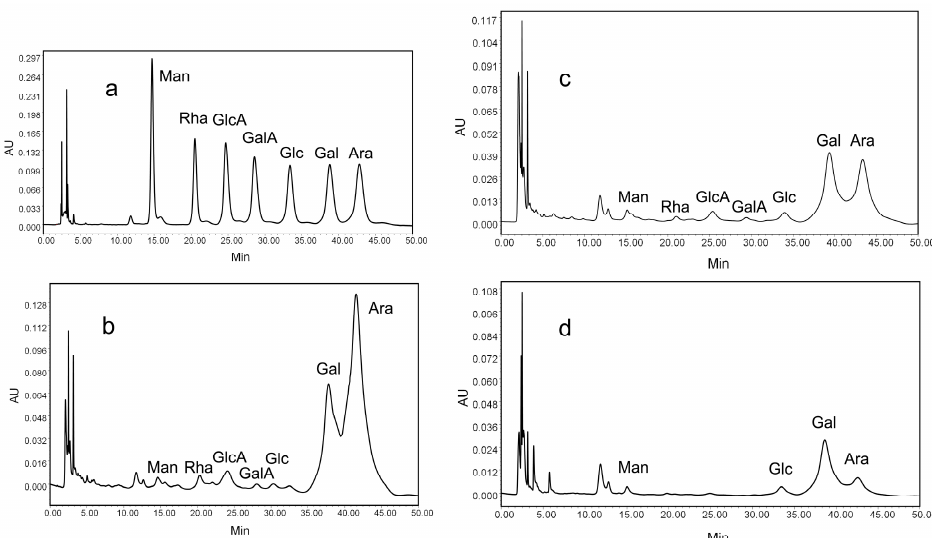
Figure 3. HPLC analysis of monosaccharide composition of standard ( a ); PRM1 ( b ); PRM3 ( c ); and PRM5 ( d ). The three polysaccharides were hydrolyzed with trifluoroacetic acid, labeled with PMP, and analyzed with a Waters e2695 HPLC